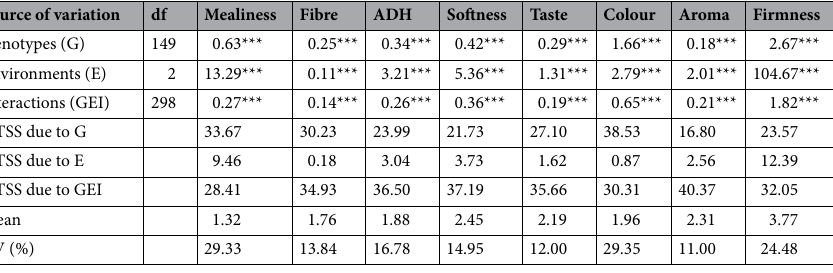
Table 1. Mean square values and percentage sum of squares contribution to total variation for root mealiness and other culinary quality traits in 150 cassava genotypes phenotyped in three environments in Nigeria. df, Degrees of freedom; ADH, Adhesiveness; %TSS, Percentage of total sum of squares explained; CV, Coefficient of variation. ***Significant level at P <